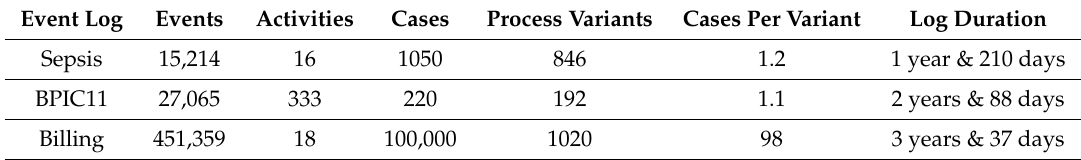
Table 2. Characteristics of the three healthcare event logs used in the